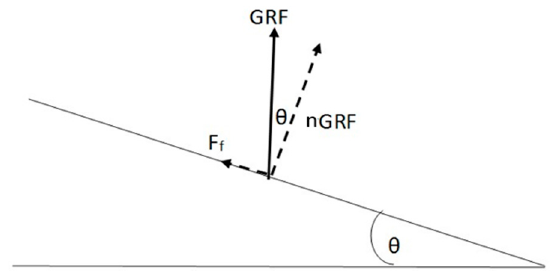
Figure 4. Overall GRF and its components (nGRF, normal GRF; F f : friction) related to the incline θ of the landing area.